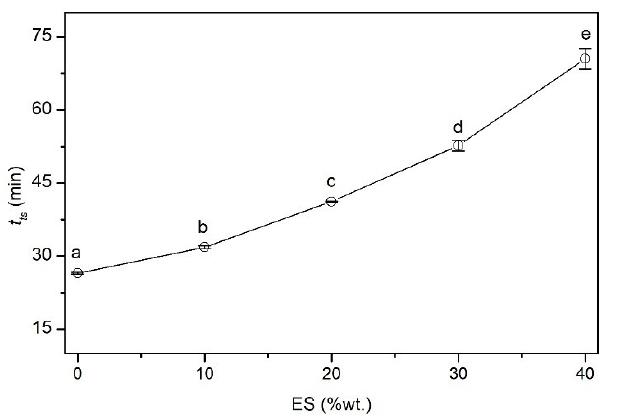
Figure 6. Time of thermal stability ( t ts ) as a function of the biofiller content in the PVC